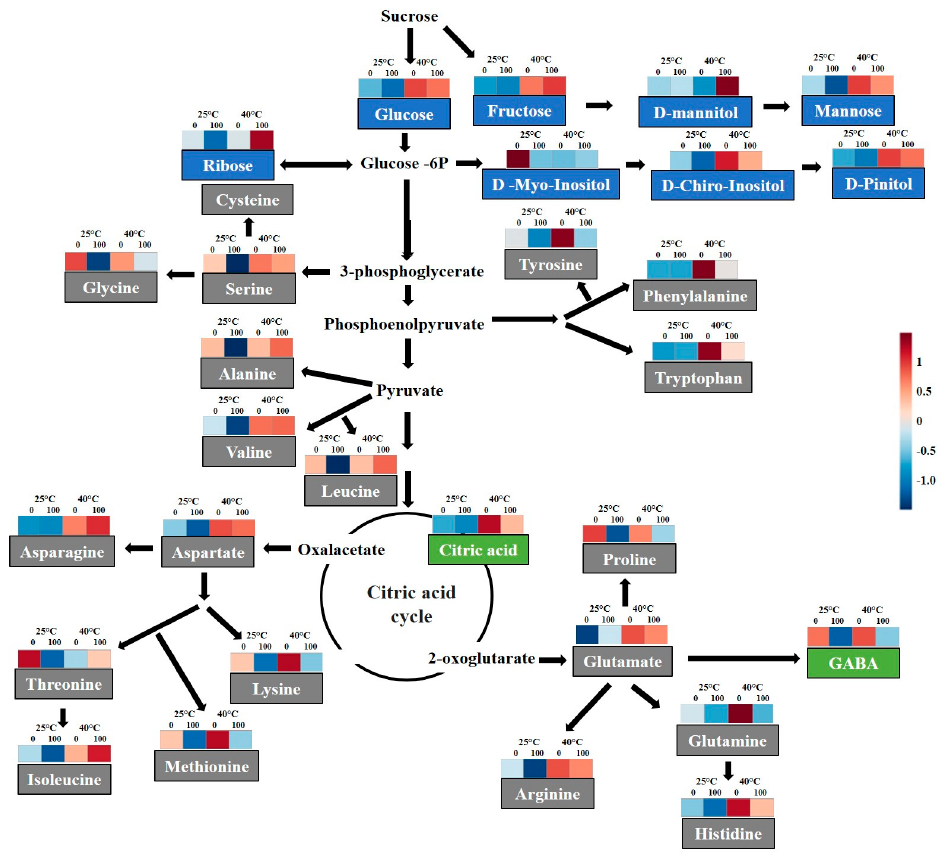
Figure 8. Schematic representation of the selected metabolic pathways with heat map of normalized compounds data integrated from soybean plants submitted to two temperatures (25 °C and 40 °C) and two SNP concentrations (0 and 100 μ M). Blue and red colors represent low and high concentrations, respectively, and scale according to the color legend. For interpretation of the references to color in this figure legend, the reader is referred to the web version of this article.